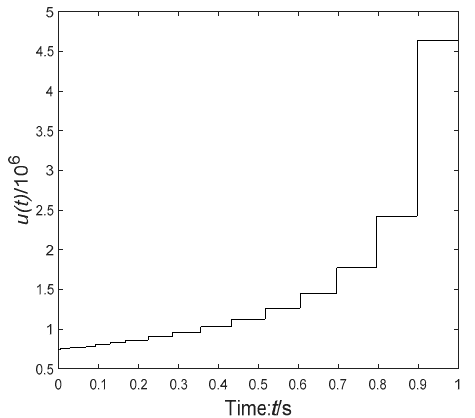
Figure 7. Optimal temperature control trajectory ( N = 20).